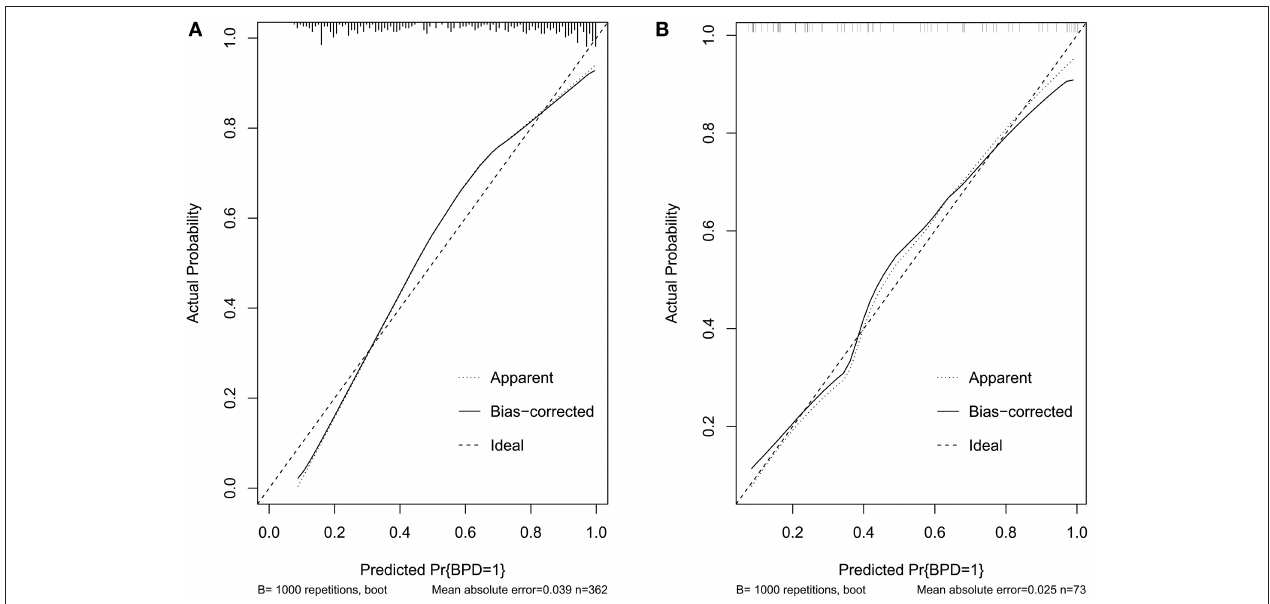
FIGURE 3 | Calibration curves of the BPD prediction model. (A) Calibration curves in the training set. (B) Calibration curves in the validation set. BPD, bronchopulmonary dysplasia; RDS, neonatal respiratory distress syndrome; CP, cerebral palsy; GA, gestational age; FiO2, fraction of inspiration O2; PMA, postnatal menstrual age; IUGR, intrauterine growth restriction; GDM, gestation diabetes mellitus; PROM, premature rupture of membranes; MODS, multifunctional organ failure; DIC, disseminated intravascular coagulation; NT-proBNP, N-terminal pro-brain natriuretic peptide; RF, respiratory failure; HF, heart failure; PDA, patent ductus arteriosus; AC, fetal abdominal circumference; EFW, estimated fetal weight; UA-AEDF, umbilical artery-absent end-diastolic flow; UtA-PI, uterine artery-pulsatility index; LASSO, least shrinkage and selection operator regression; BNP, B-type natriuretic peptide; PS, pulmonary surfactant; MV, mechanical ventilation; SurE, surfactant without endotracheal tube intubation; NAVA, neurally adjusted ventilatory